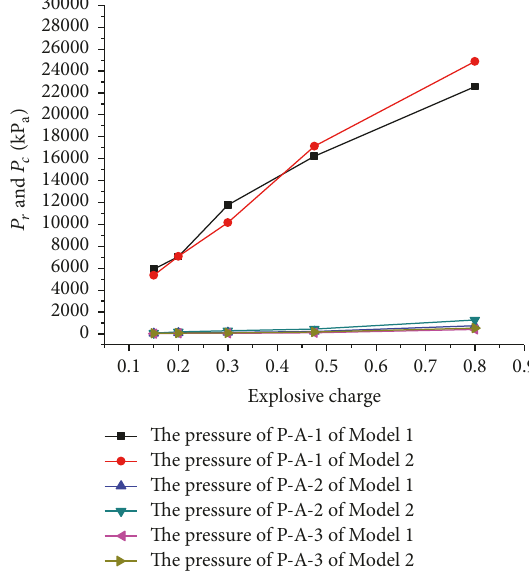
The pressure of P-A-1 of Model 1 The pressure of P-A-1 of Model 2 The pressure of P-A-2 of Model 1 The pressure of P-A-2 of Model 2 The pressure of P-A-3 of Model 1 The pressure of P-A-3 of Model Figure 19: Pressure of each measurement